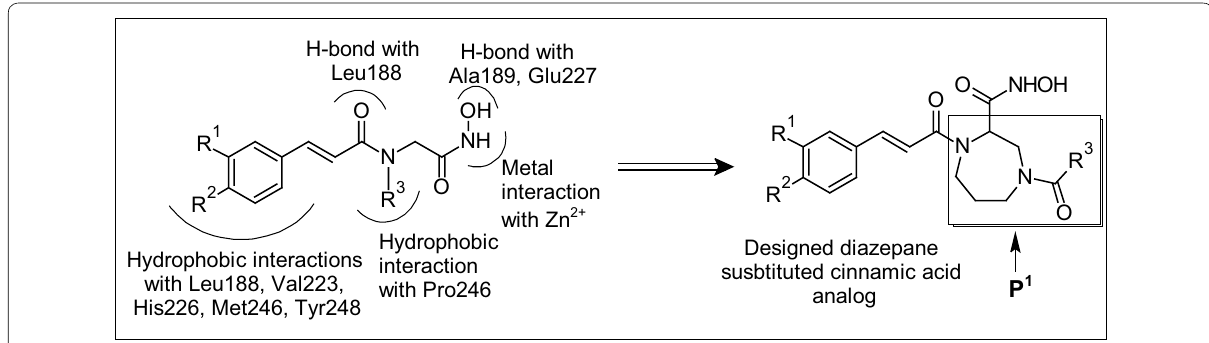
Fig. 1 General structure of the designed diazepine substituted cinnamic acid